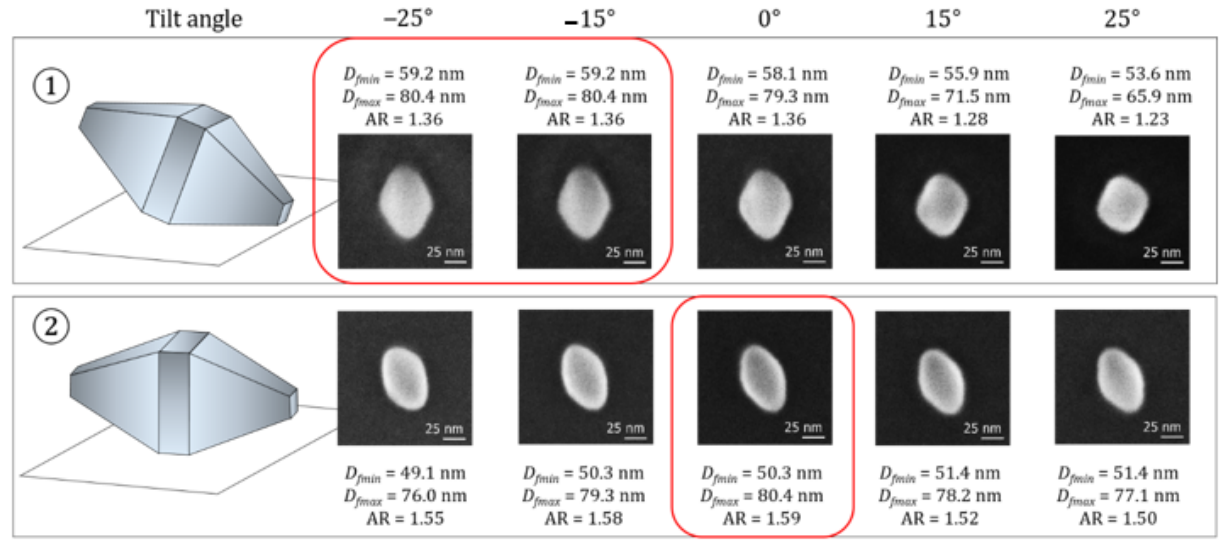
Figure 9. Changes in the 3 kV SEM images of TiO 2 NPs performed after tilting the stage of the instrument between –25° and +25° in five steps. An example for each orientation ① and ② is given.